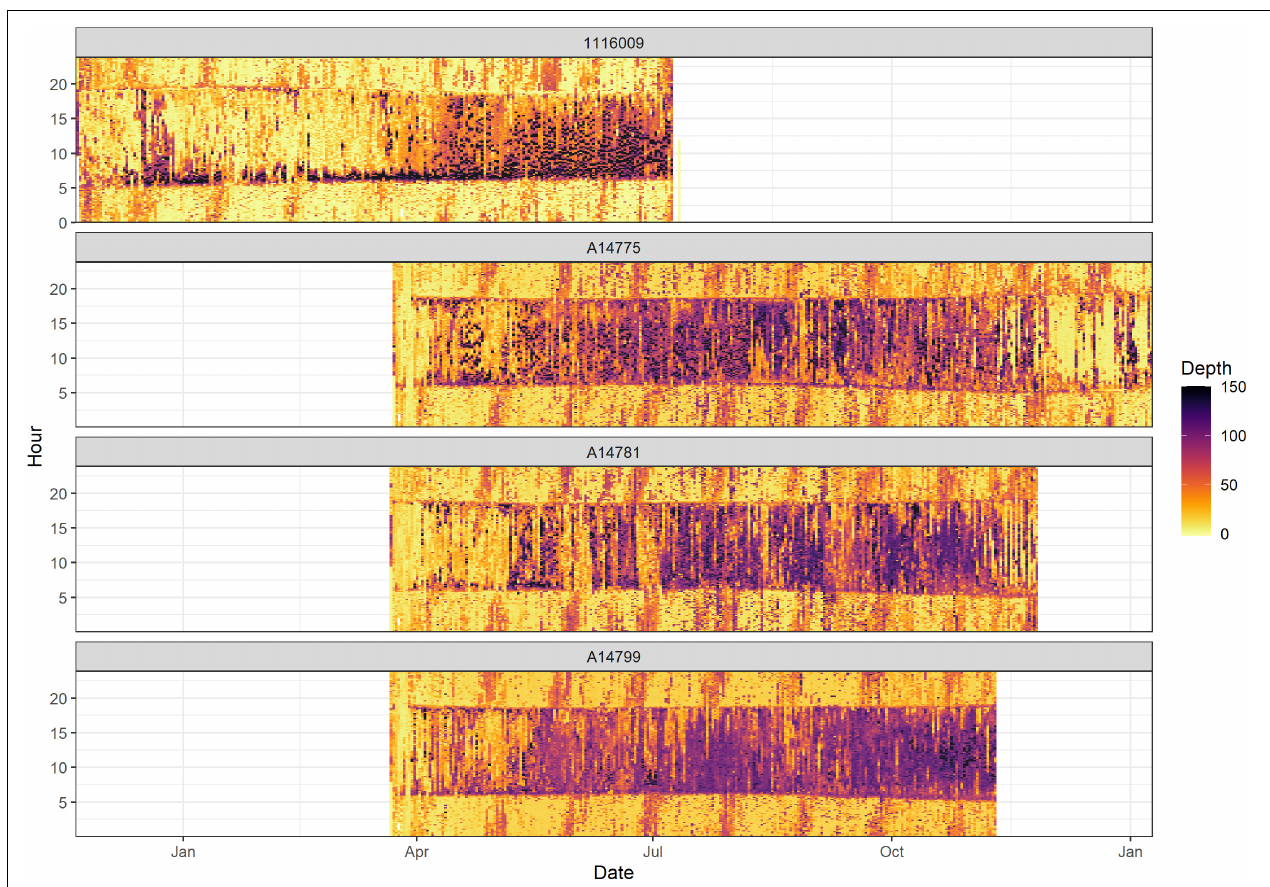
FIGURE 3 | Actogram showing the depth utilisation of yellowfin tuna 1116009, A14775, A14781, and A14799. Month is shown on the X axis and hour of the day is shown on the Y